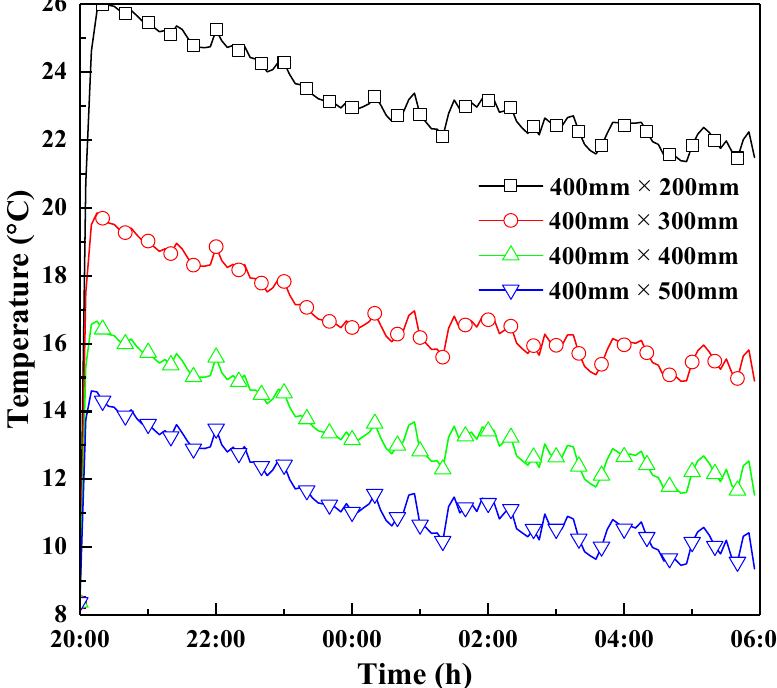
Figure 20. Time-dependent variation of the component surface temperature with different widths of the radiative plate.